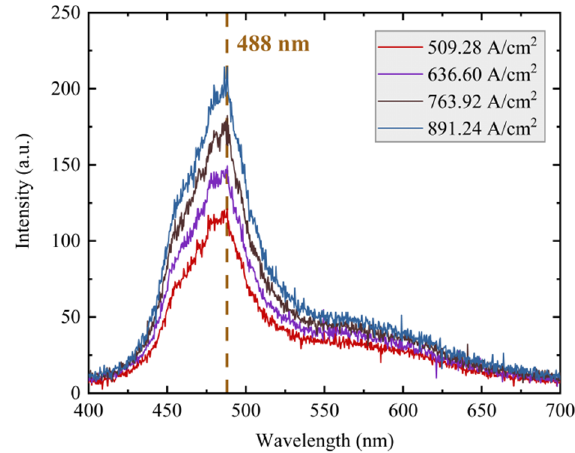
Figure 4. The spectrum of the package 100- μ m micro-LED.